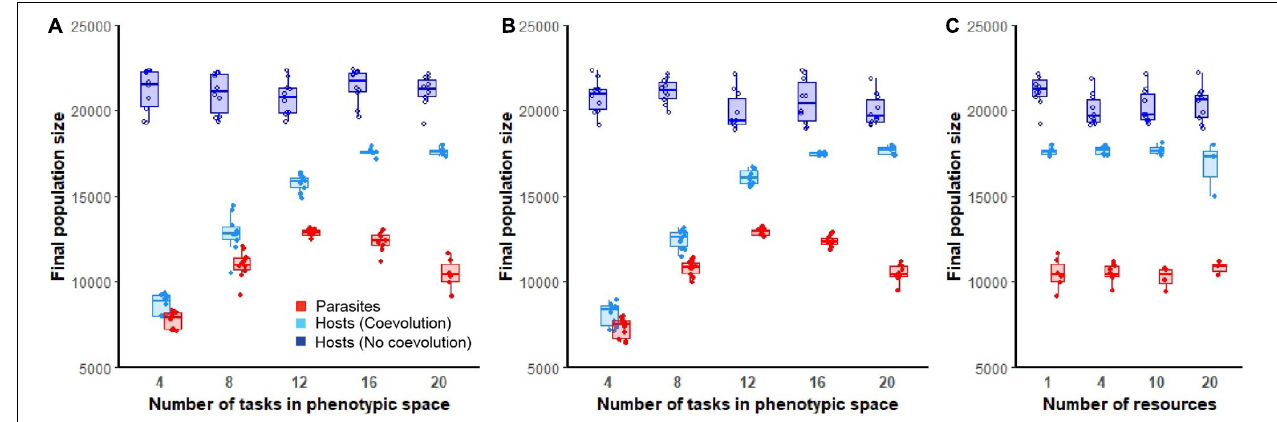
FIGURE 3 | Final host and parasite population sizes. Boxplots show final population sizes (at the end of 300,000 updates) for hosts (non-coevolving in dark blue, coevolving in light blue) and parasite populations (red). In (A,B) , ecological complexity was held constant at either one or four resources, respectively, while varying the available phenotypic space (4, 8, 12, 16, or 20 tasks). In (C) , the available phenotypic space was held constant at 20 tasks and final populations are shown for increasing levels of abiotic complexity (4, 8, 10, or 20 resources). Only data from those host populations in which parasites did not go extinct are shown.